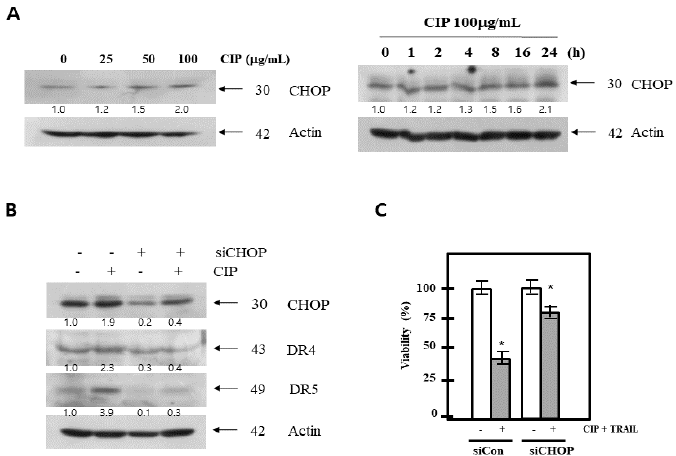
Figure 5. CIP exposure led to the regulation of CHOP proteins expression. ( A ) The effects of CIP on the expression levels of CHOP proteins. A549 cells were treated with various concentrations of CIP. Equal amounts (40 µ g) of cell lysates were separated by SDS-PAGE. The images shown are representatives of two additional experiments which yielded similar results. ( B ) A549 cells were transfected with CHOP siRNA. After 48 h, the cells were pretreated with CIP for 24 h. Whole cell extracts were analyzed by western blotting using antibodies against CHOP, DR4, and DR5. ( C ) A549 cells were transfected with CHOP siRNA. After 48 h, cells were treated with CIP + TRAIL for 24 h. Cell death was determined by Annexin V/PI staining. The bar represents the mean ± SD. * p < 0.01 indicates a significant difference between the untreated group and CIP + TRAIL-treated samples.